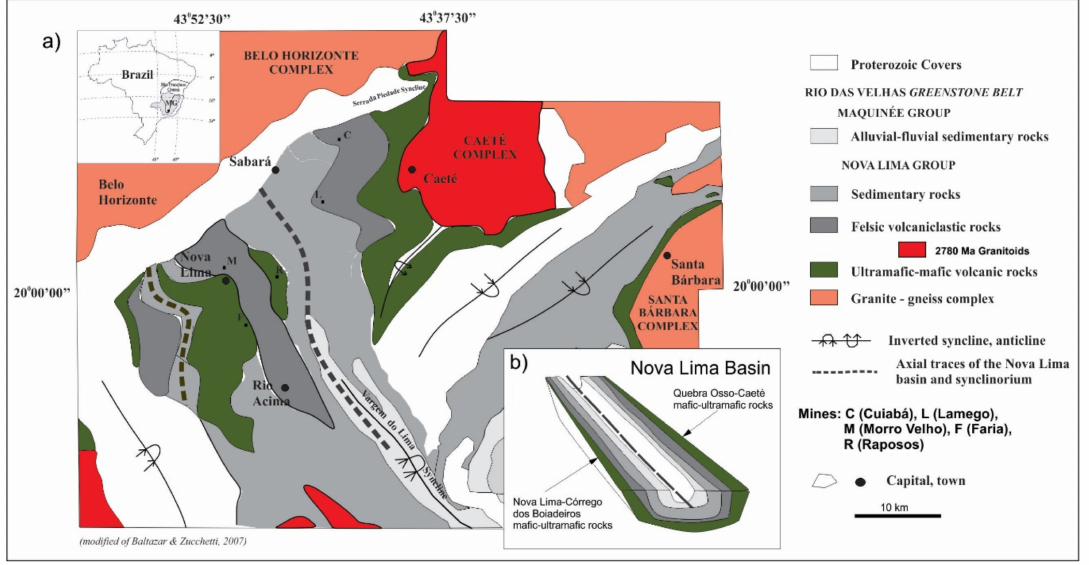
Figure 8. ( a ) Simplified geological map of the northern portion of the Rio das Velhas greenstone belt emphasizing the distribution of volcanic, volcaniclastic and sedimentary strata. ( b ) Nova Lima Basin visualization from the strata